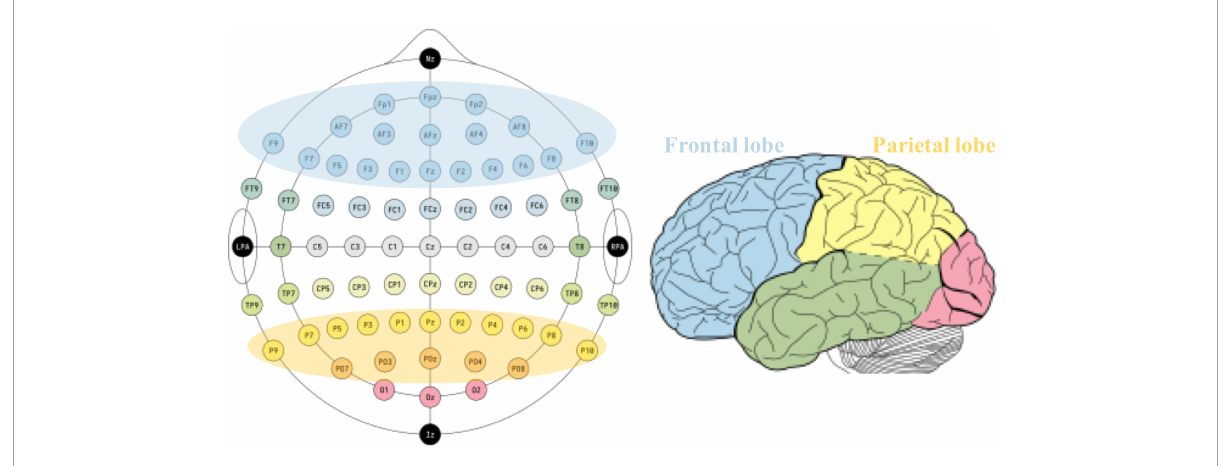
FIGURE1 Defined frontal and parietal regions according to typical 10–20 EEG system (left) and the corresponding cortex (right)